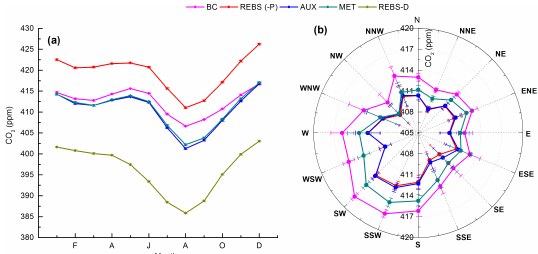
Figure 6. (a) Variations of locally influenced CO 2 mole fractions in four methods. The data are CO 2 mole fractions smoothed by the curve-fitting method of Thoning et al. (1989). REBS-P denotes local events in or above regional band in REBS in Fig. 3, and REBS-D denotes local events below the regional band. (b) Wind-rose dis- tribution of locally influenced CO 2 mole fractions by the four ap- proaches at LAN. The REBS-P and REBS-D show similar distribu- tions. Thus the local events are averaged together as REBS to avoid a jump in the scale (red dots and line). Error bars indicate confi- dence intervals of 95%.